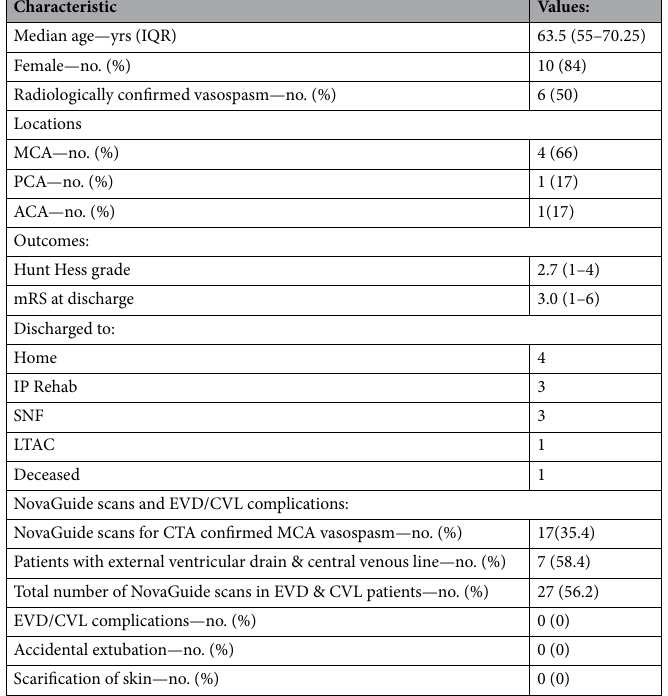
Table.1. Patient characteristics and outcomes. IP Rehab In-patient rehabilitation, SNF Skilled nursing facility, LTAC Long term acute care, EVD External ventricular drain, CVL Central venous